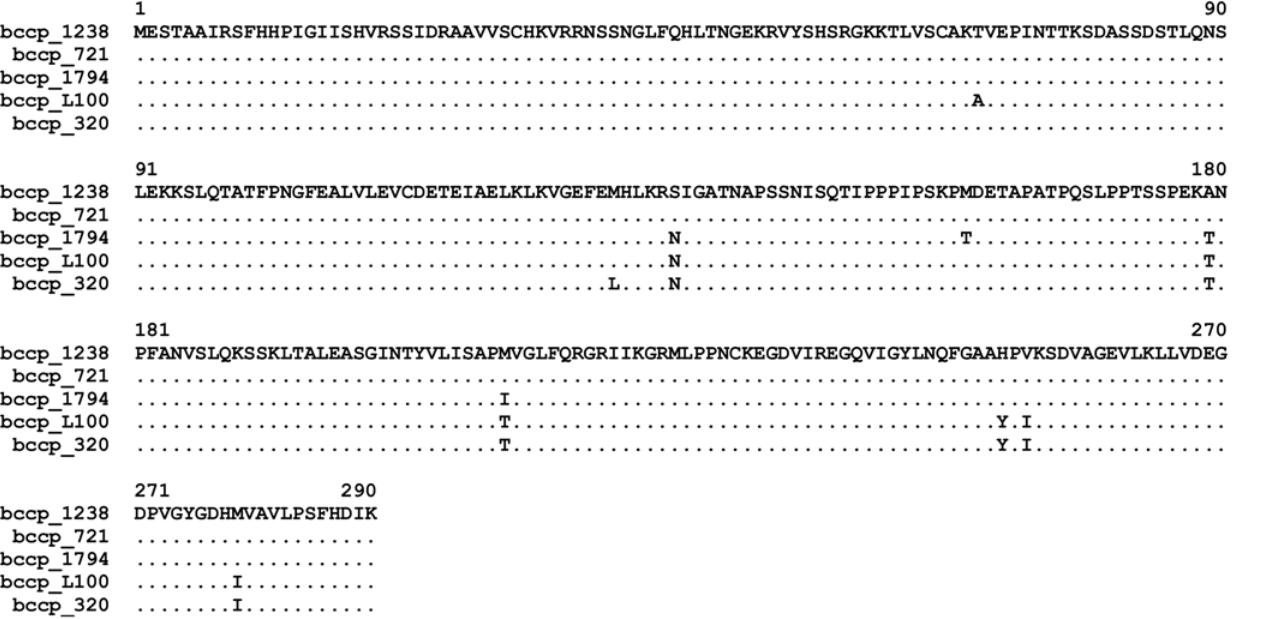
Fig 3. Alignment of the derived amino acid sequences encoded by Bccp3 alleles of the accessions studied. Dots indicate amino acid residues identical to those of